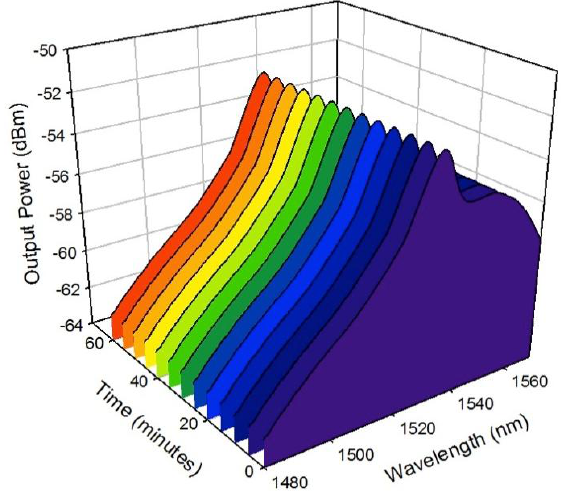
Figure 6. The stability measurement of the ASE spectrum within 60 min of observation time.